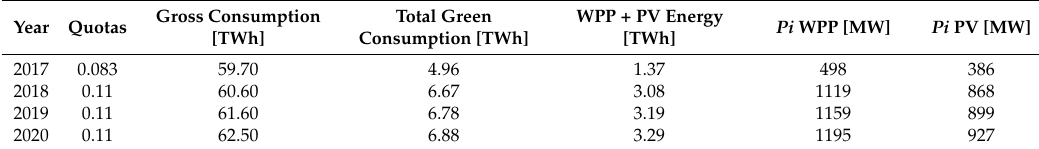
Table 5. Simulation of Pi of other RES variation